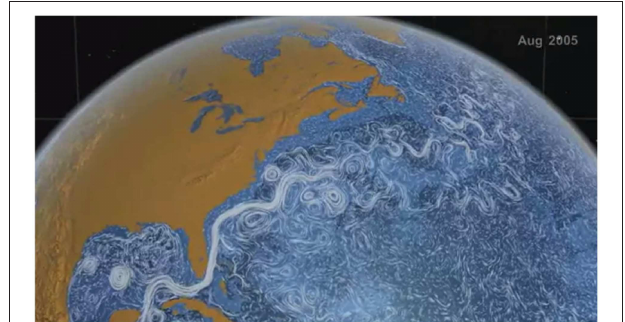
FIGURE 3 | Snapshot (August 2005) of visualization of ocean surface currents for June 2005 through December 2007 generated using NASA/JPLs Estimating the Circulation and Climate of the Ocean, Phase II (ECCO2) ocean model.